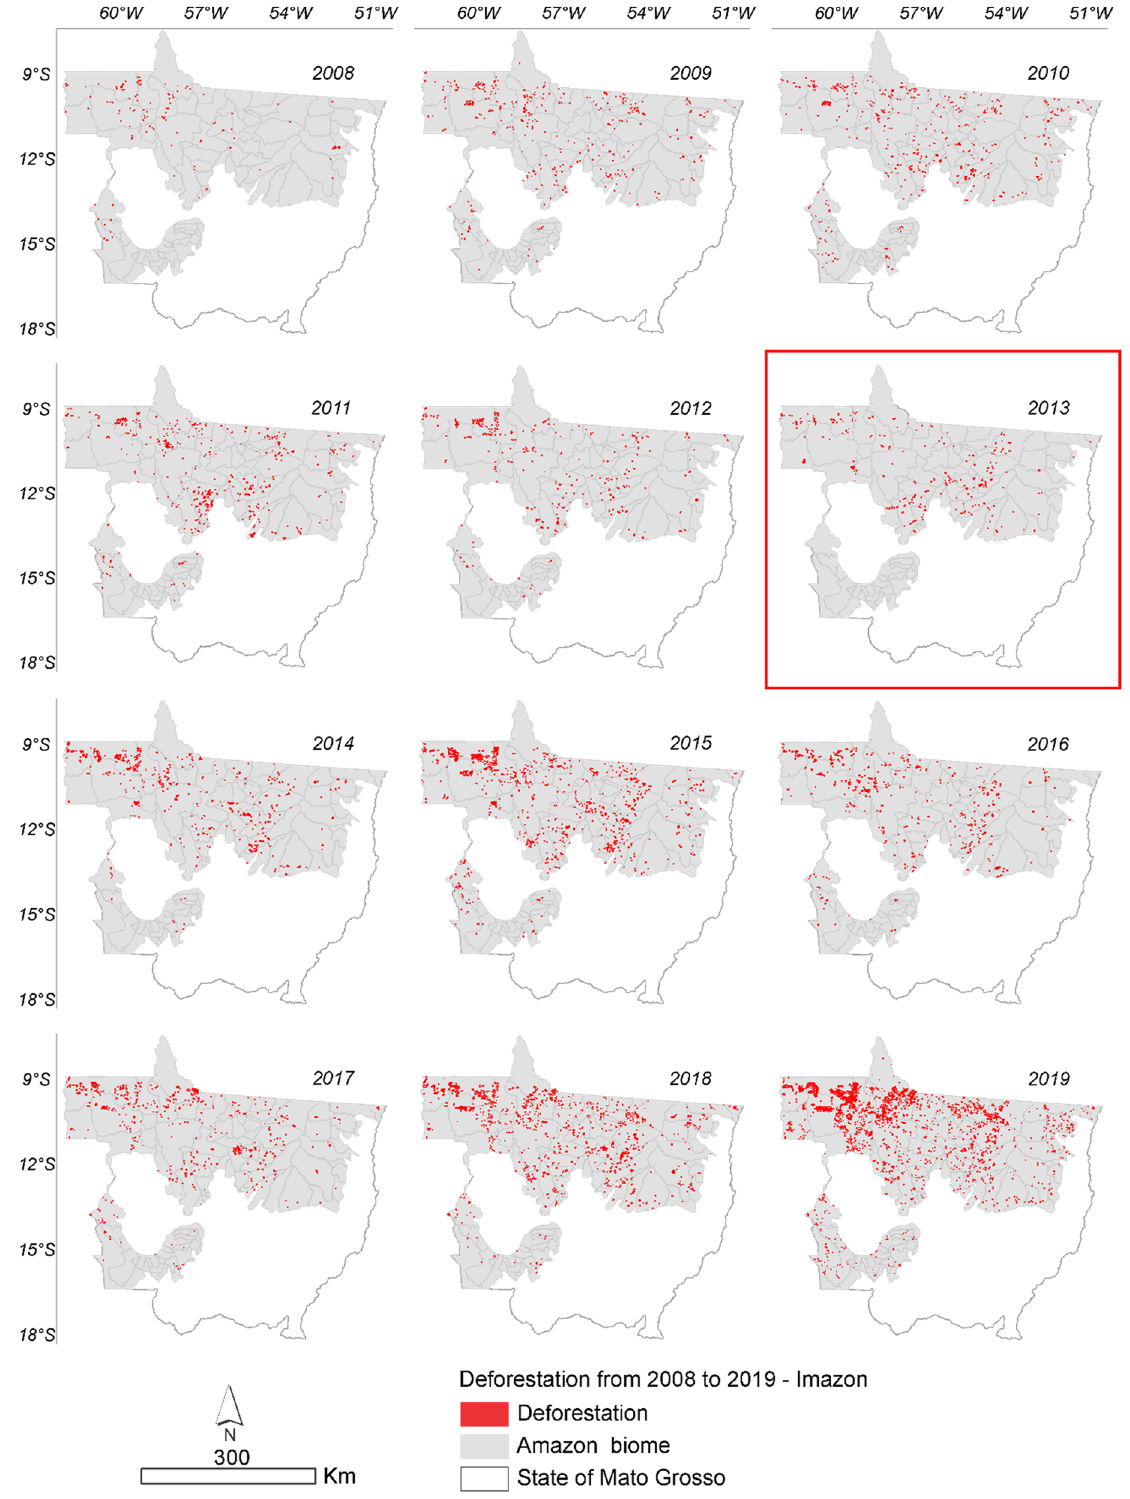
Figure 2. Annual deforestation in the Amazonia biome in the State of Mato Grosso from August 2008 to October 2019 with data from ImazonGeo. The highlighted year corresponds to the likely point of change in the time series identified by the Pettitt test (Table